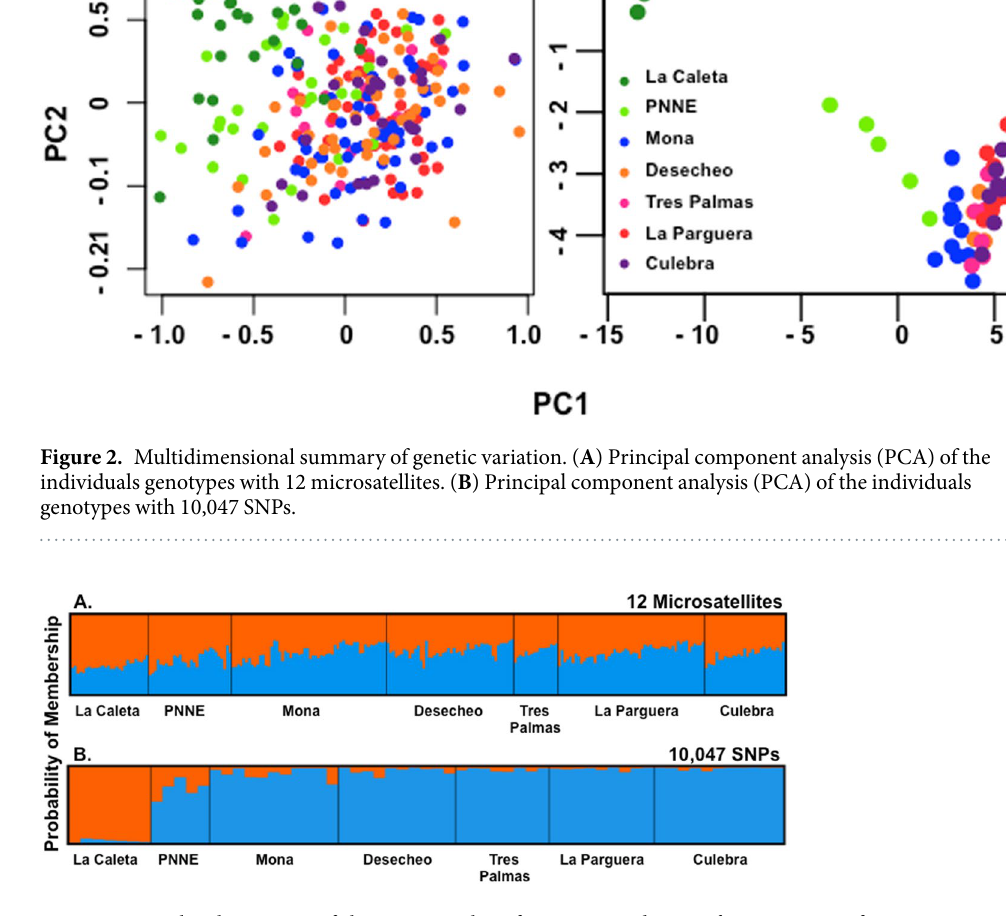
Figure 3. Graphical summary of clustering Analysis for Opistognathus aurifrons genotypes from seven Marine Protected Areas along Mona Passage using Structure. Probability of Membership of each sampling site (n = 7) from individuals per site scored with 12 microsatellites ( A ) and 10,047 SNPs ( B ). Each vertical line represents an individual and the estimated proportion of the individual’s genome from each inferred